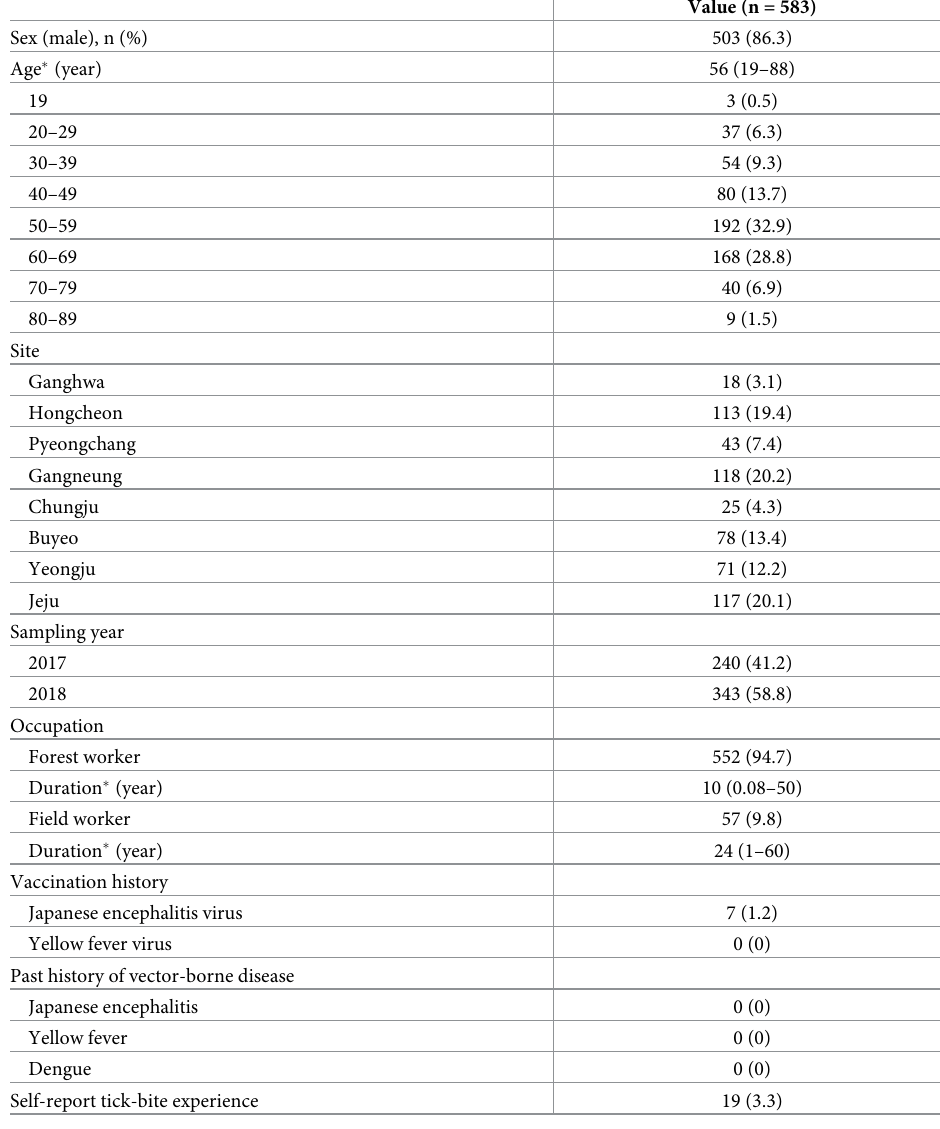
Table 1. Demographic characteristics of the study